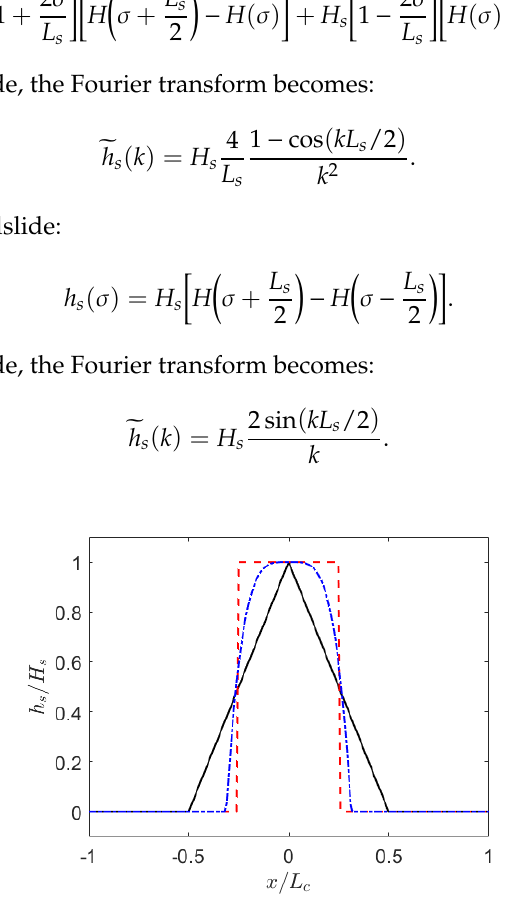
Figure 1. Three different shapes of landslide. Figure 1. Three di ff erent shapes of